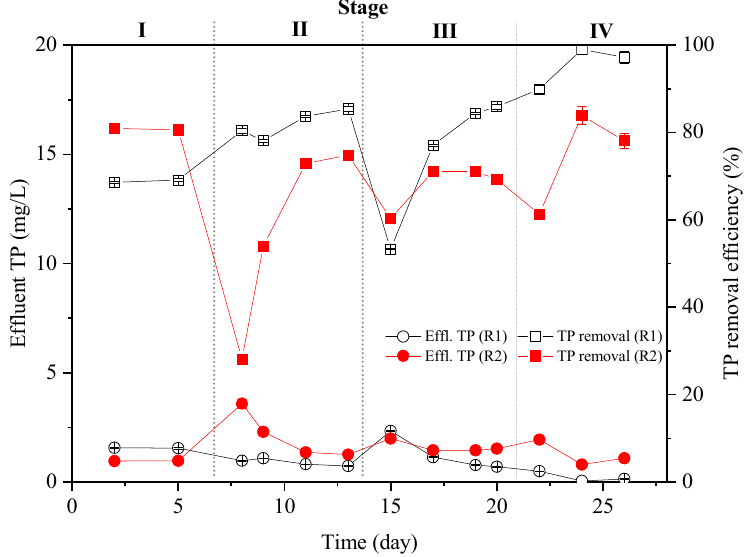
Figure 6. Profiles of the effluent P concentrations from R1 and R2, and their TP removals during the 28 days of operation.